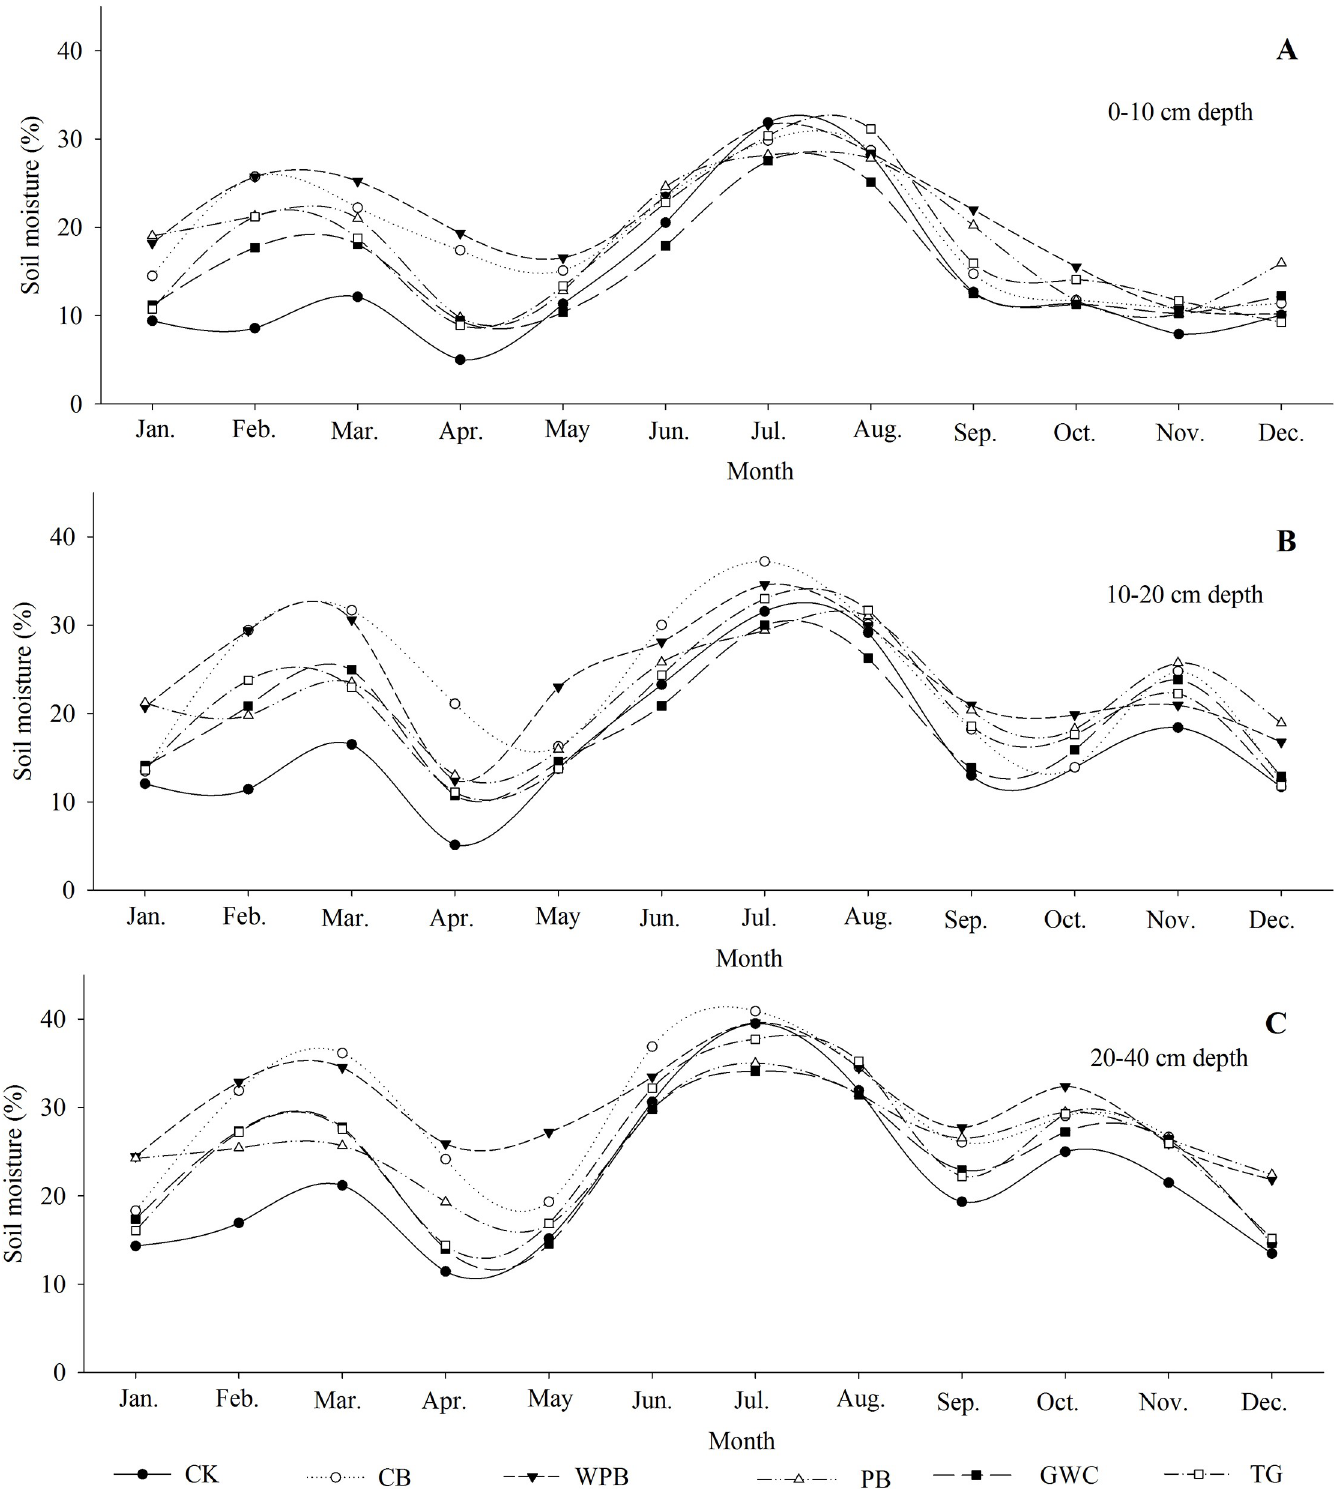
Fig 2. Monthly soil moisture content at three different depths in the urban tree pits treated with bare soil (CK), cobblestones (CB), water permeable bricks (WPB), pine barks (PB), green waste compost (GWC), and turf grass (TG) in 2015.